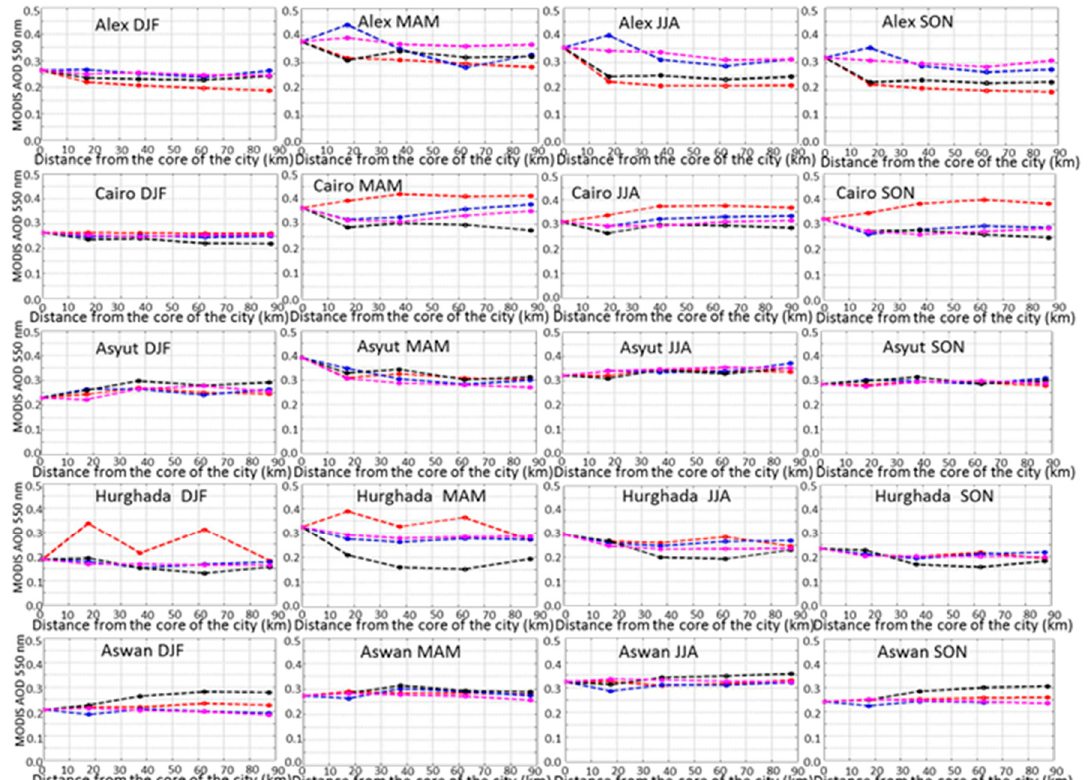
Figure 11. Spatial gradient of AOD over the five selected cities. The gradient is measured along the four cardinal directions: east (red), west (blue), north (black), and south (magenta). For the location of the measurement points, refer to Figure 6.